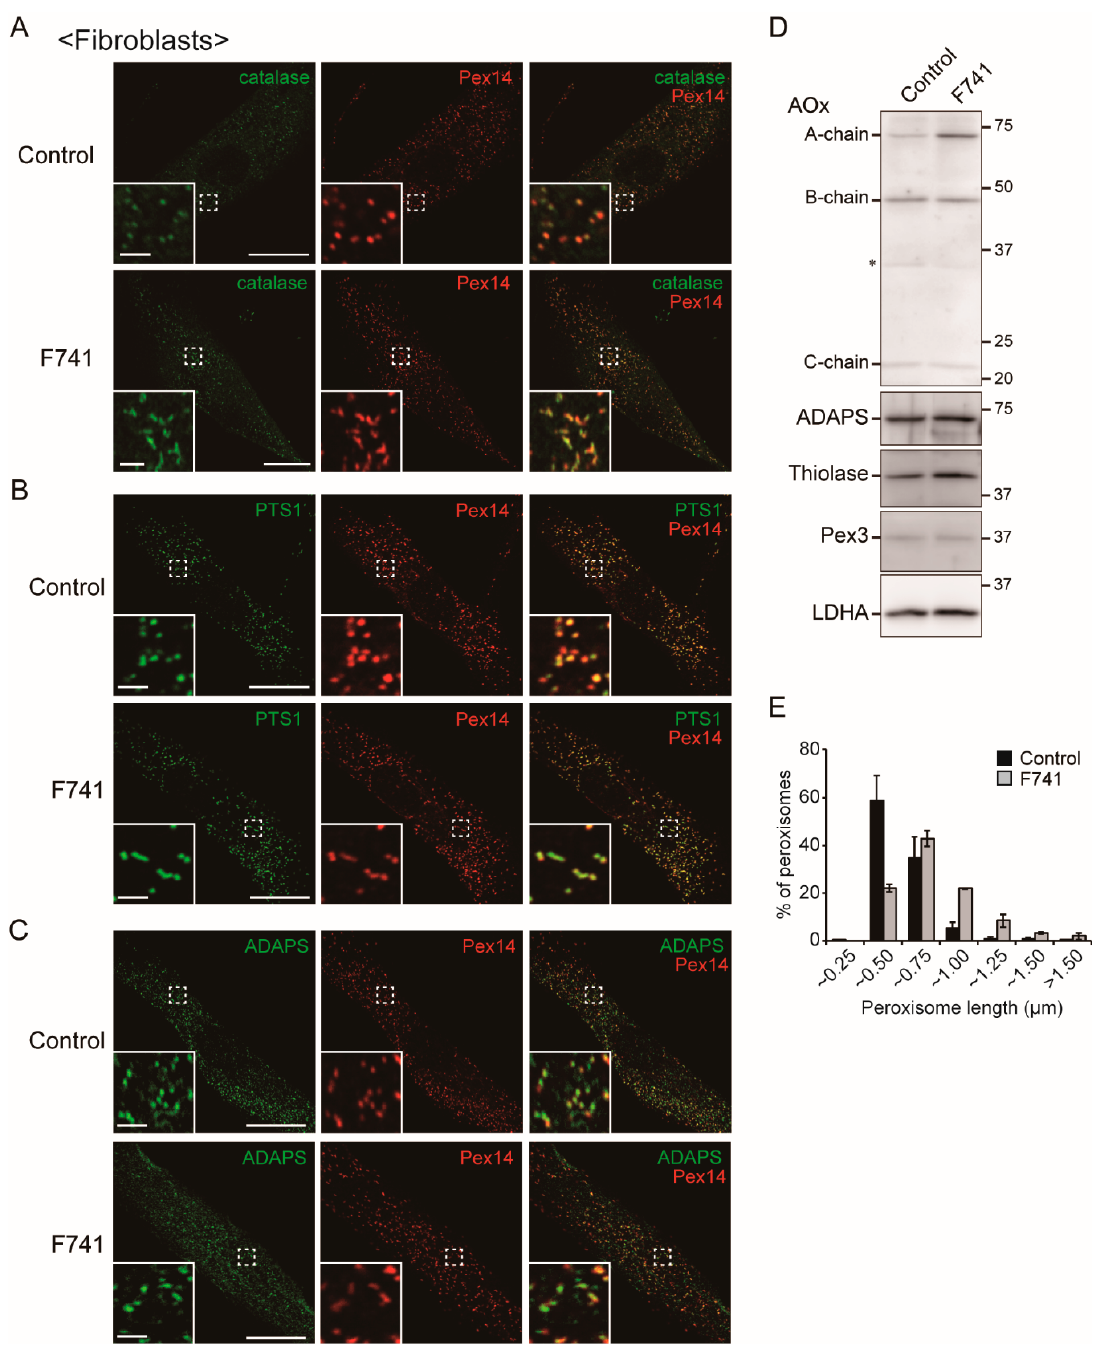
Figure 2. Aberrant morphology of peroxisomes in NME3-deficient fibroblasts. ( A – C ) peroxisomes in the fibroblasts from a healthy control (upper panels) and a patient F741 (lower panels) carrying a homozygous mutation in the initiation codon of NME3 were visualized by indirect immunofluorescent staining with antibodies to catalase ( A ), PTS1 ( B ), ADAPS ( C ) and Pex14 ( A – C ). Insets show the images of the boxed areas. Bars, 20 µm and 2 µm (insets). Elongated peroxisomes are frequently observed in the patient-derived fibroblasts. ( D ) proteolytic processing of AOx, thiolase, and ADAPS was accessed by immunoblotting of cell-lysates of fibroblasts from a healthy control and the patient with antibodies to AOx, ADAPS, thiolase, Pex3, and LDHA, respectively. LDHA was used as a loading control. ( E ) histogram of peroxisome length measured in three each fibroblasts from a healthy control (1400 peroxisomes in three cells) and a patient F741 (1038 peroxisomes in three cells).